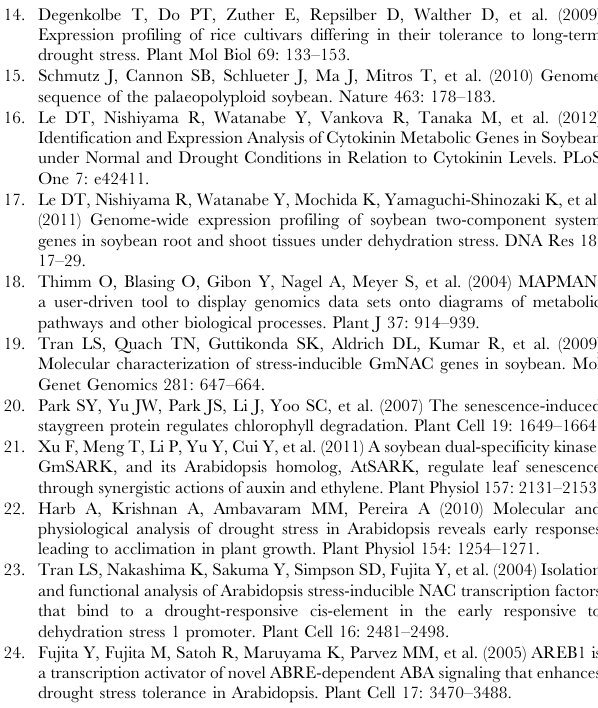
Table S1 Expression data of annotated soybean genes in V6 leaves under drought stress. Data received from